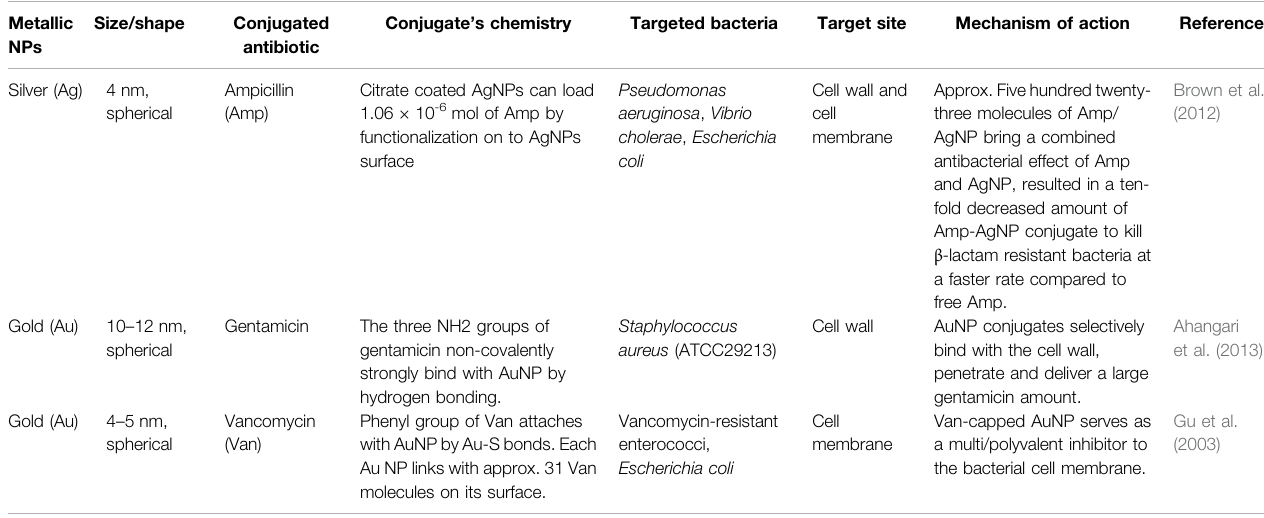
TABLE 2 | Different types of metallic nAbts and their associated functions. Metallic NPs